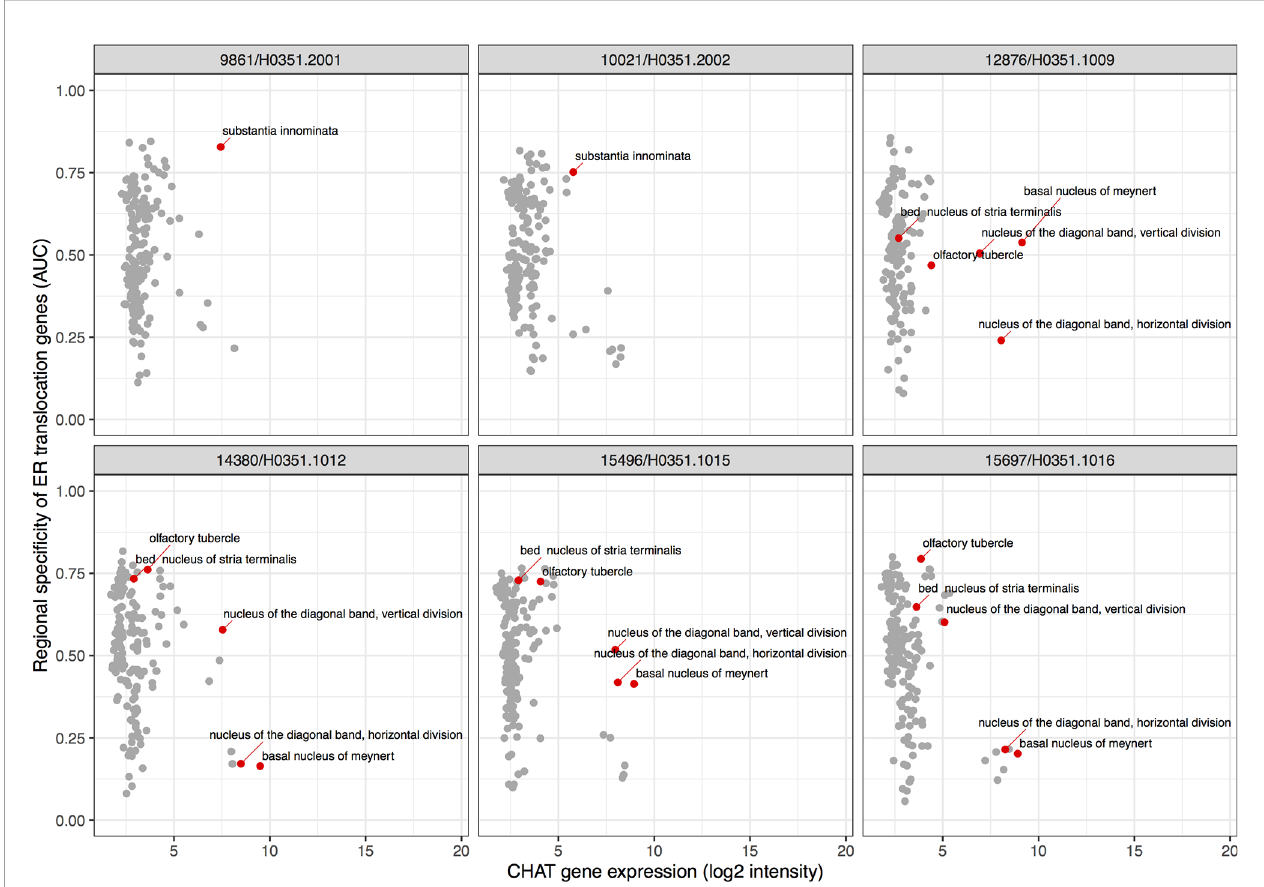
FIGURE 3 | Scatter plots showing speci fi c enrichment for ER translocation genes (y-axis) and Choline O-Acetyltransferase ( CHAT ) gene expression on the x-axis in each brain. Each point is a brain region with red marking the substantia innominata and its